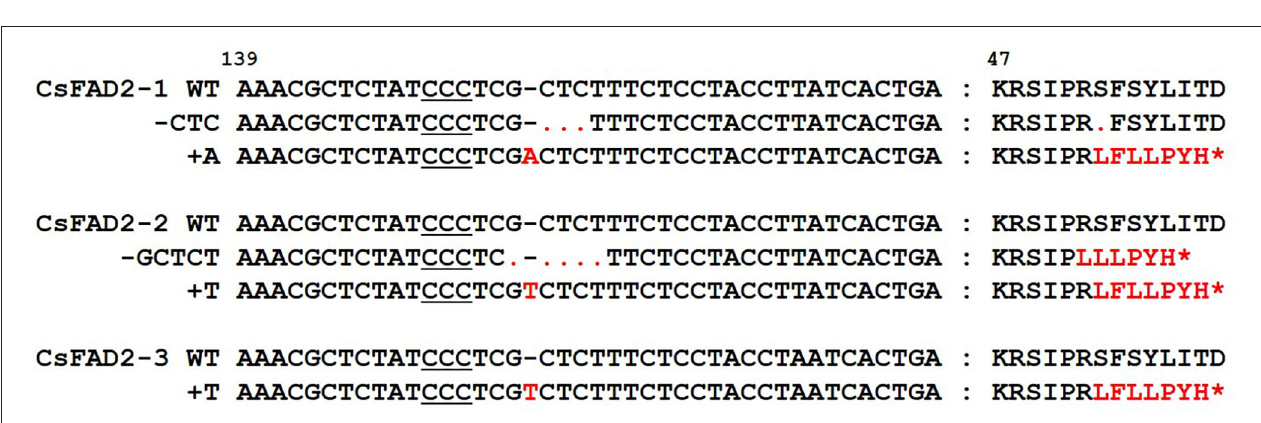
FIGURE 6 | Fatty acid analysis of CsFAD2 KO T 4 Camelina leaves. (A) Fatty acid composition of CsFAD2 KO Camelina leaves. (B) MUFA and PUFA contents of CsFAD2 KO Camelina leaves. Minor peaks, 16:1, 16:2, and 18:0 peaks were omitted. Black, green, blue, and brown bars represent WT, aa/bb/CC, aa/bb/Cc, and aa/bb/cc, respectively. The line numbers of green, blue and brown bars are in order as follows. Green bar, EC#5-1-5-2 (EC# is omitted hereafter), 5-6-14-2, 5-6-24-4, and 5-7-9-4; blue bar, 5-1-6-1, 5-6-14-7, 5-6-2-41, 5-7-9-3, 5-26-10-5, 5-26-10-6, 5-44-24-4, and 5-44-24-6; brown bar, 5-26-10-1, and 5-6-14-3. Fatty acid composition was analyzed in triplicate, and error bars indicate standard deviation.